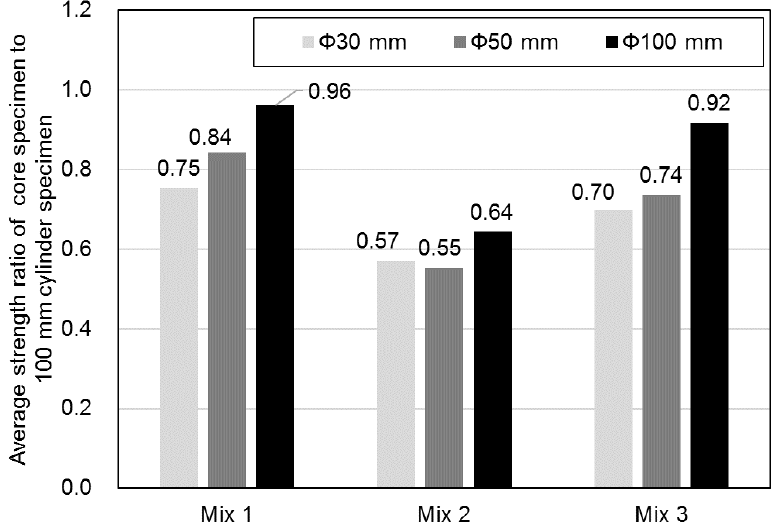
Figure 8. Compressive core strength of concrete and strength ratio for the three types of mix proportions.